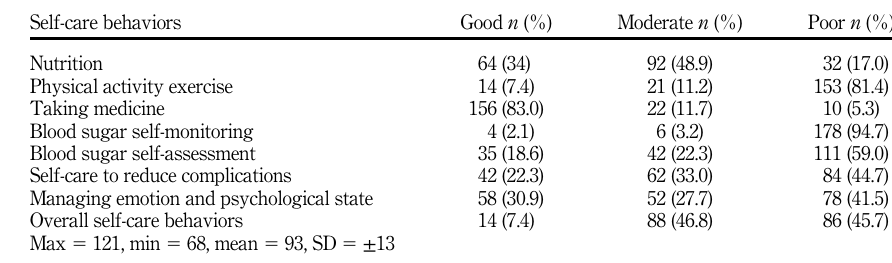
proportions of the sample and self-care behaviors